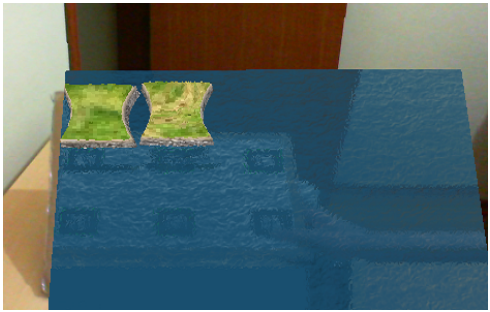
Fig. 11. Deformation using the hyperboloid volume function.